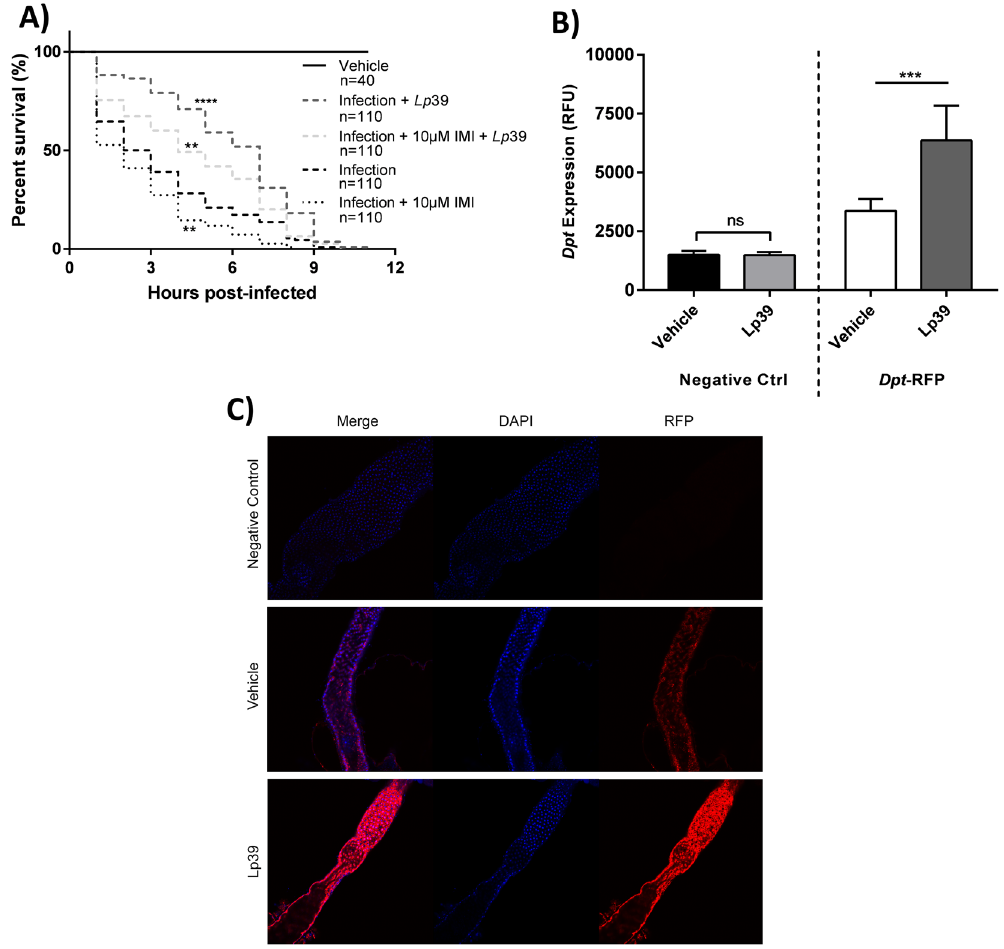
Figure 7. Lp39 supplementation mitigates IMI-induced D . melanogaster survival deficits following infection. ( A ) Survival curves for newly eclosed WT Canton-S flies that were subjected to septic infection with Serratia marcescens NCIMB 11782 while concurrently exposed to IMI and/or supplemented with Lp39 separately or in combination, compared to infected WT-Canton control and vehicle (septic injury alone). All statistical symbols are representative of comparison made to infected WT Canton-S controls. Statistical significance was determined using the log-rank (Mantel-Cox) test. ( B ) Dpt expression of newly eclosed Dpt -RFP reporter flies was determined following 15 h oral supplementation of Lp39 or vehicle. WT Canton-S flies were used as a negative control. Gene expression was quantified by fluorescence intensity using a microplate reader. Mean ± standard deviations (two-way ANOVA) from 7 biological replicates (10 flies each replicate) per group are shown. ( C ) Newly enclosed Dpt -RFP and negative control WT Canton-S flies were orally supplemented with Lp39 or vehicle for 15 h. Midguts were dissected, nuclear counterstained with Hoechst 33342, trihydrochloride, tetrahydrate and viewed by confocal microscopy. Scale bar = 20 µ m. ** p < 0.01, *** p < 0.001, **** p <